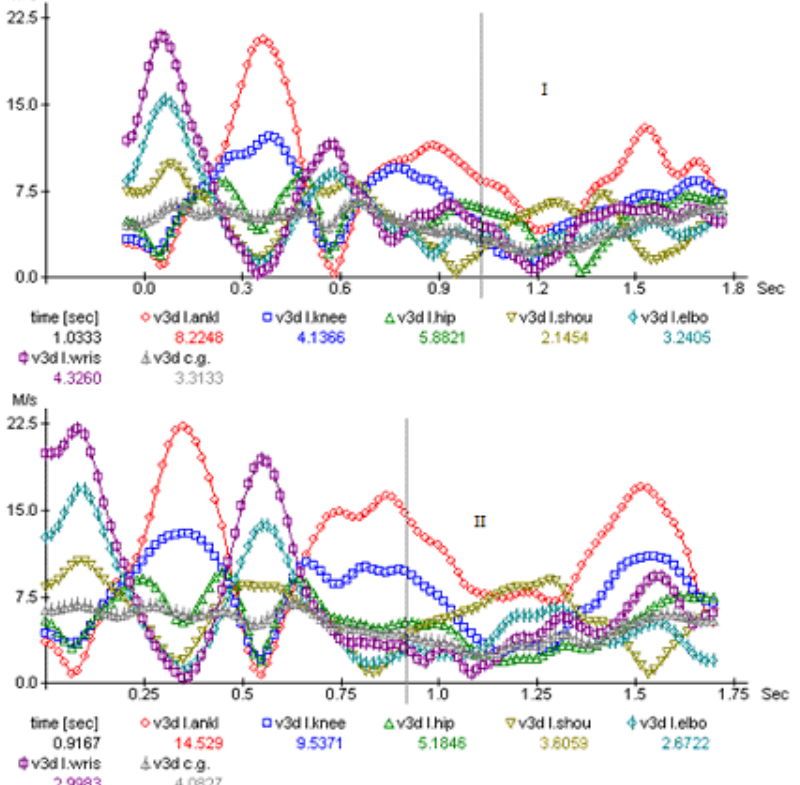
Fig.4. Resultant speed values of ankle, knee, hip, shoulder, elbow and wrist joints, GMC in phase of main movements; MP in grouped back double somersault after rondat (tested A, upper section of figure, time – 1. 033sec.)and arched back double somersault after rondat – back turnover (tested B, lower section of figure, variant 2, time - 0.